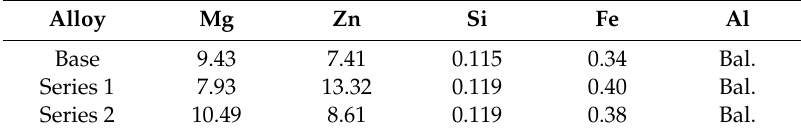
Table 1. Chemical compositions of the Al-Zn-Mg alloys in wt.%.